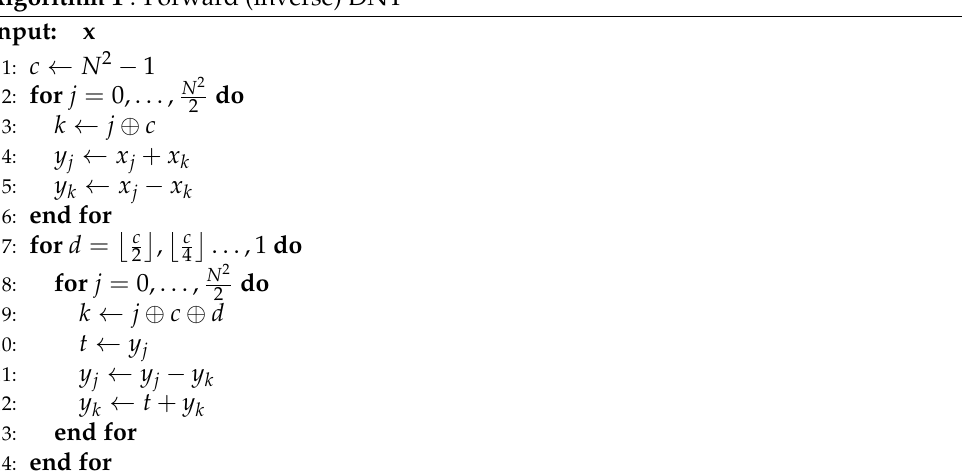
Algorithm 1 : Forward (inverse)